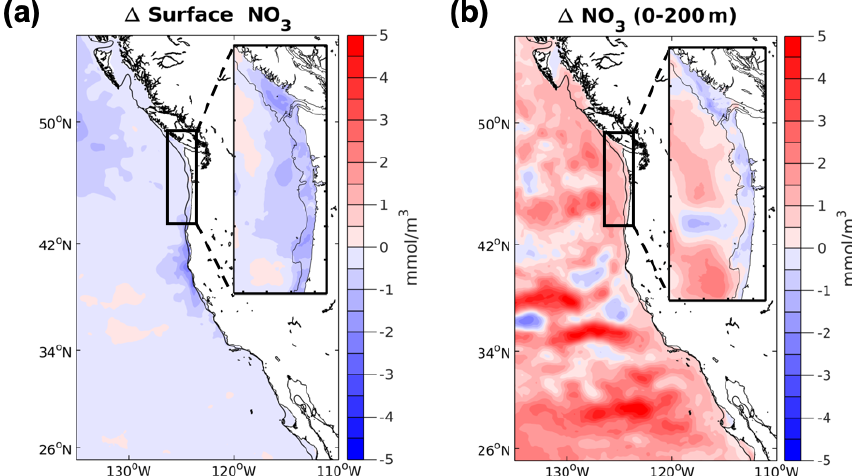
Figure 6. Projected changes in nitrate for the CCS. Differences between the future and the base/present nitrate (NO 3 ) conditions for the 12km (CCS-wide, full panel) and 1.5km (N-CCS, inset) projections (a) at the surface and (b) depth-averaged (0–200m). Positive values indicate a change that is greater in the future than the base/present condition, and negative values indicate lower values in the future than the base/present condition.